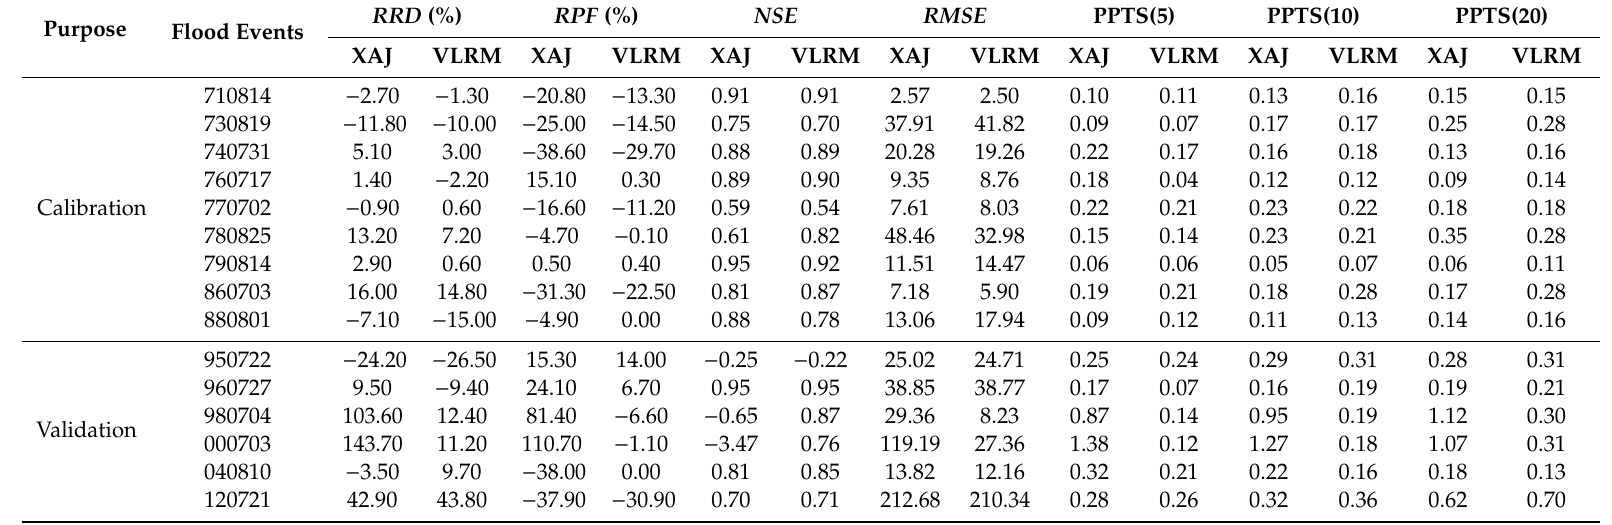
Table 2. Performance measures of XAJ and VLRM models in Zijingguan